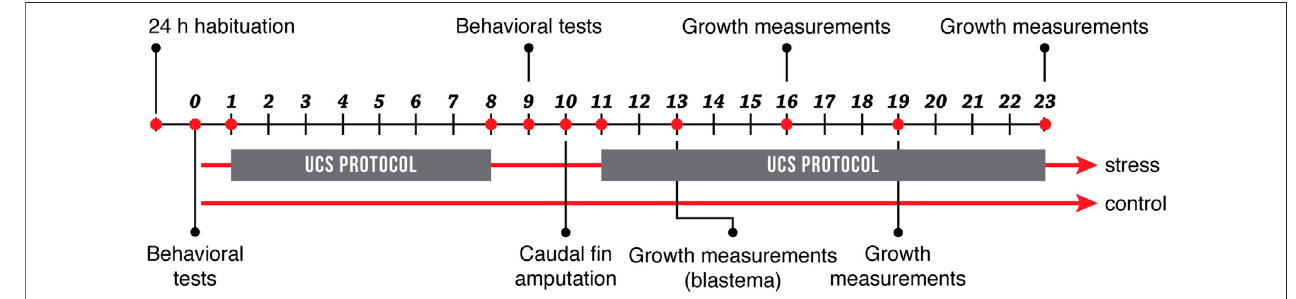
FIGURE1| Experimentaldesign.Fishinthestressgroupwereexposedtoan8-daystressprotocol(UCS),while fi shinthecontrolgroupremainedunderstandard conditions. All fi sh were subjected to behavioral tests before and after the stress protocol. On day 10, caudal fi ns were amputated, and growth measurements were recorded on days 13, 16, 19, and